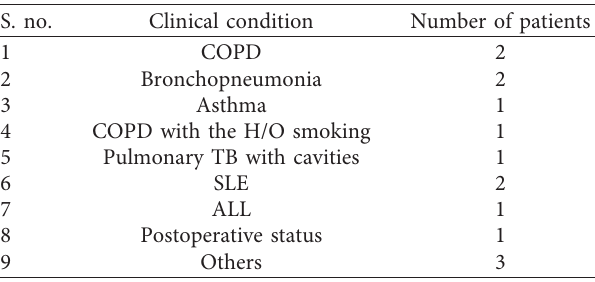
Figure 3: Age distribution of patients in whom M. catarrhalis was isolated. Table 1: Clinical condition of patients from whom M. catarrhalis was isolated.